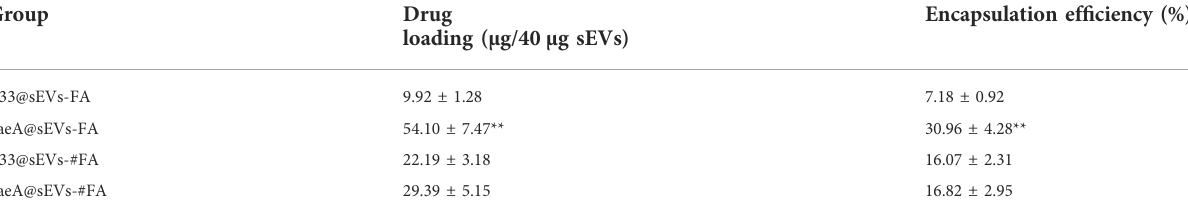
TABLE 2 Loading ef fi ciency of sEVs for active